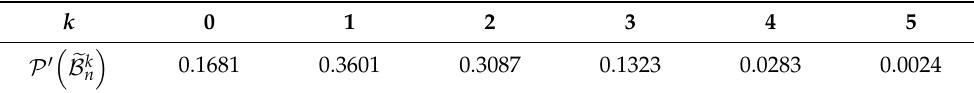
Table 1. Conditional fuzzy binomial probability distribution.